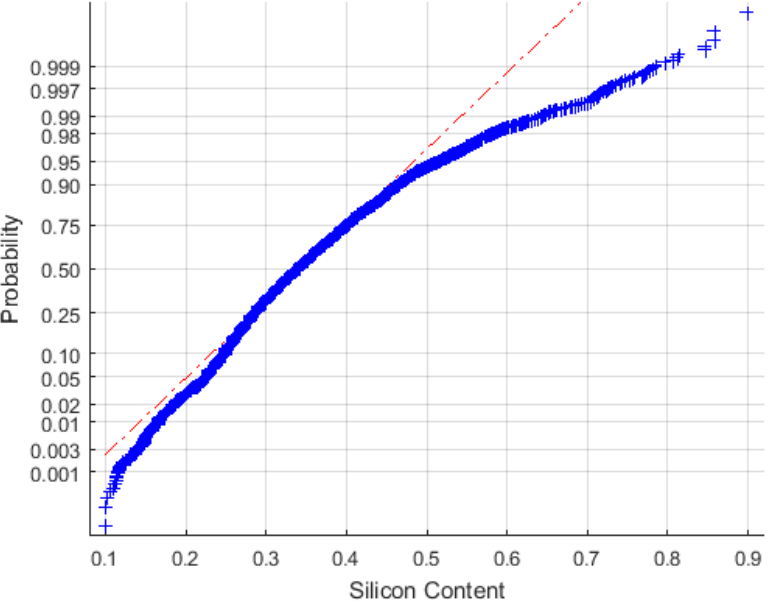
Figure 3. Q-Q plot of silicon content time